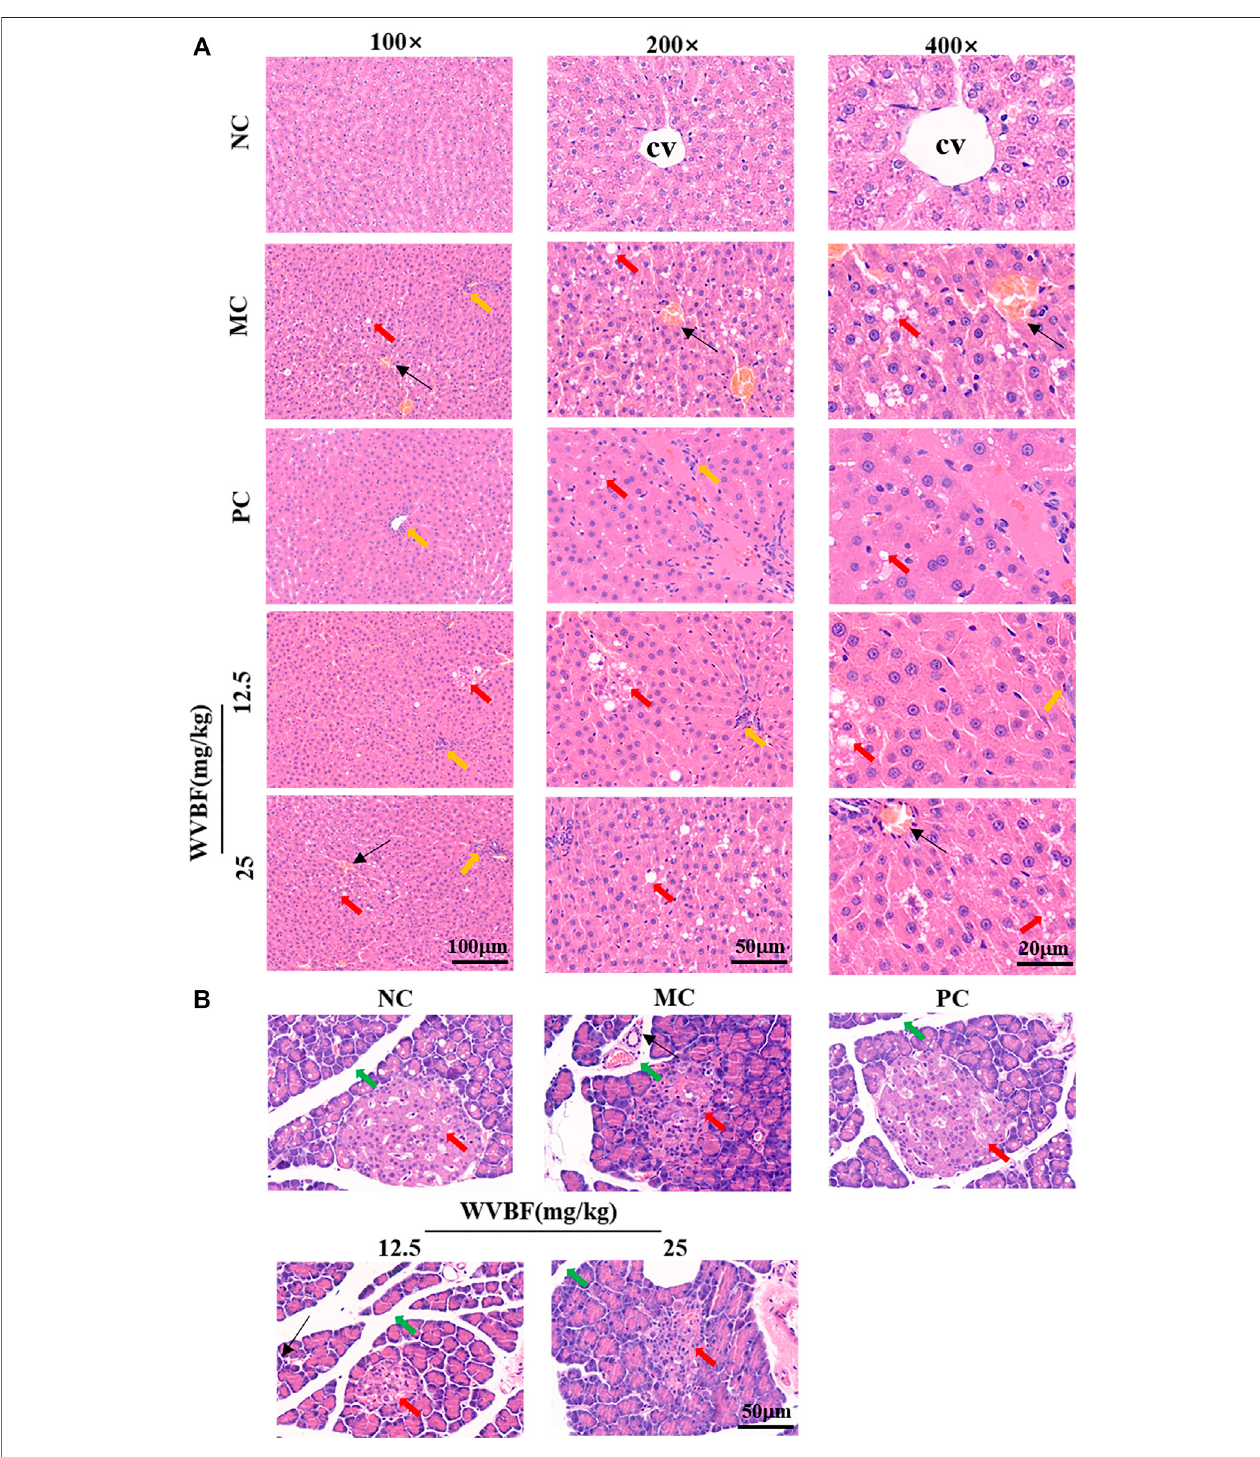
FIGURE 2 | Effect of WVBF treatment on the hepatic and pancreatic morphology in diabetic rats (A) . H&E staining of liver from different groups. Upper panel, hematoxylin and eosin, 100 × ; middle panel, hematoxylin and eosin, 200 × ; Bottom panel, hematoxylin and eosin, 400 × . CV indicates central vein; Red arrow indicates edema; Yellow arrow, in fl ammatory cells in fi ltration; Black arrow head indicates hyperemia. Bottom panel, (B) . H&E staining of pancreas from different groups. Red arrow, pancreatic acini; green arrow, intralobular duct of the pancreas; black arrow head, in fl ammatory cells. Hematoxylin and eosin, 100 × . NC: normal control, MC: mellitus control, PC: positive control, 12.5: WVBF 12.5 mg/kg/day, 25: 25 mg/kg/day.